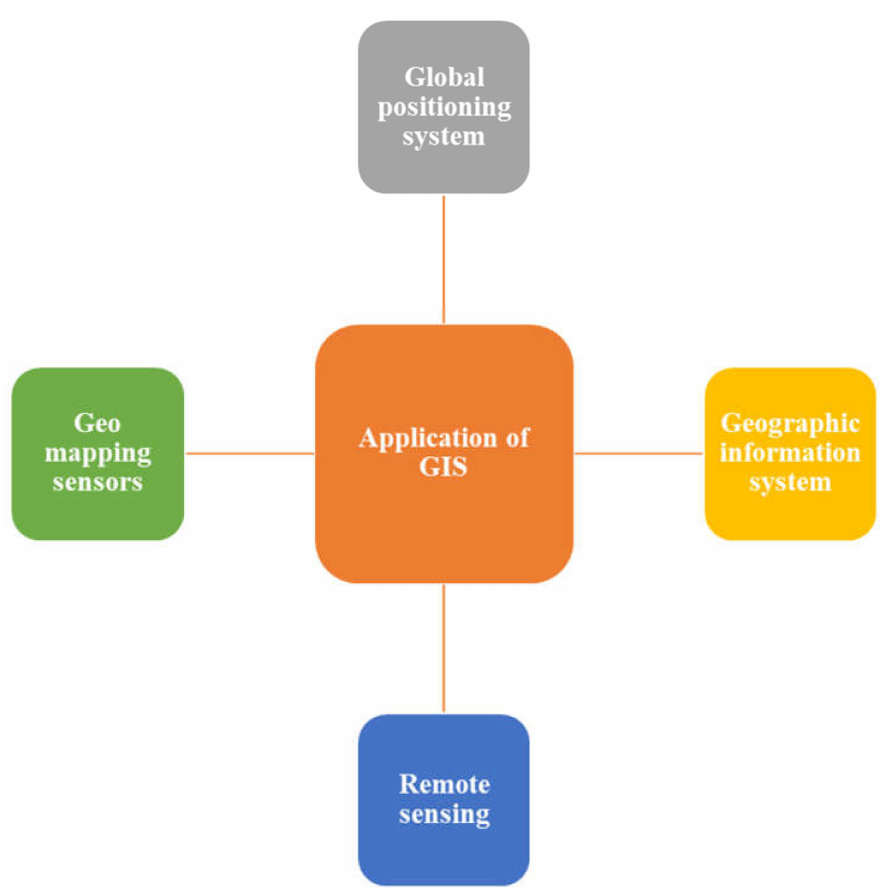
Figure 4. Application of GIS in the agriculture